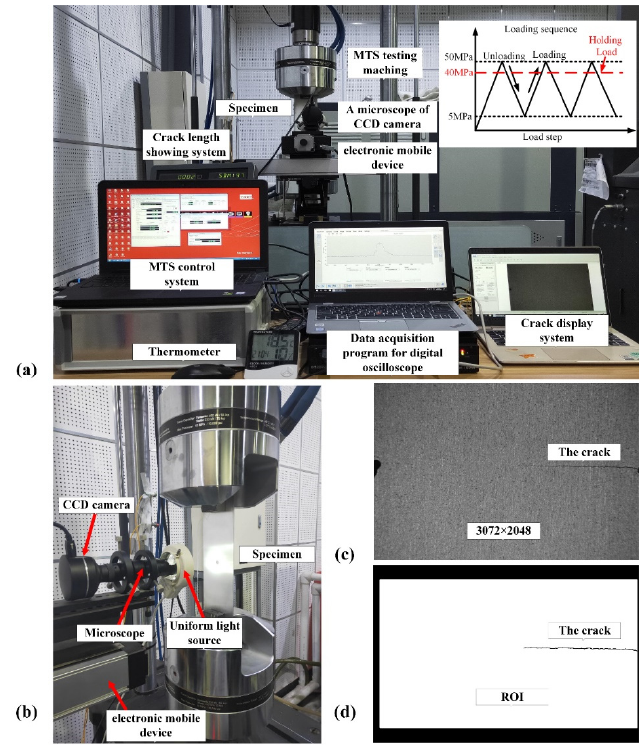
Figure 3. Experimental setup of strain measurement using the DIC technology. ( a ) A photo of the test setup, ( b ) DIC processing system, ( c ) the digital image recorded by the Charge Coupled Device (CCD) camera, and ( d )the region of interest (ROI) corresponding to Figure 3c.